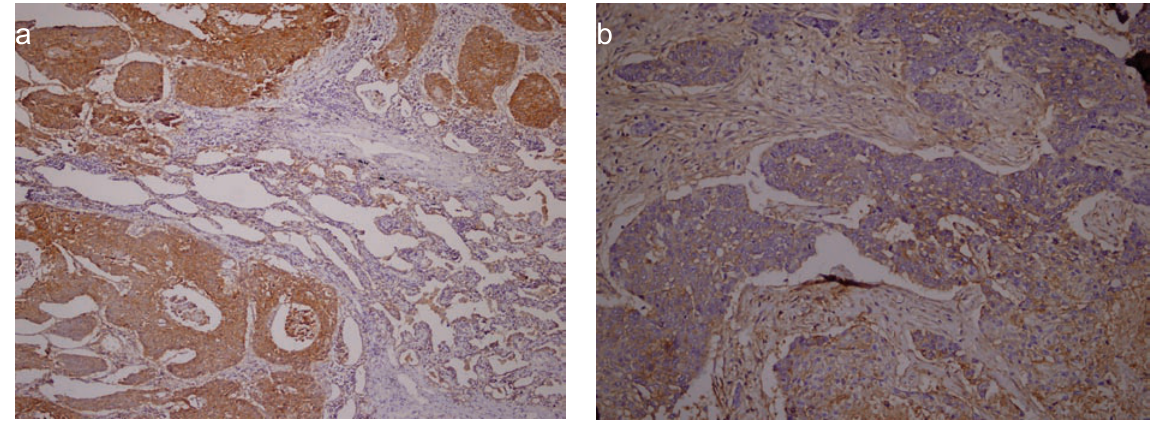
Figure 3. Strong (3a) and weak (3b) EMMPRIN staining in squamous cell carcinoma (DAB, x100 and x200). ba